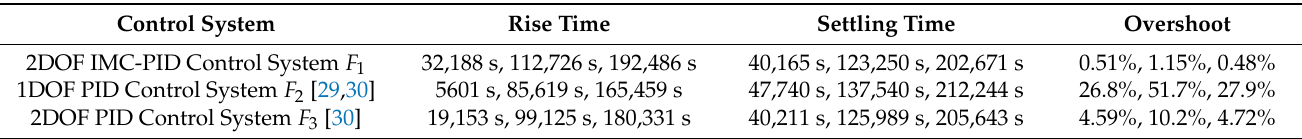
Table 7. Performance of three control systems F i ( i = 1,2,3 ) in DSD reaction networks. Control